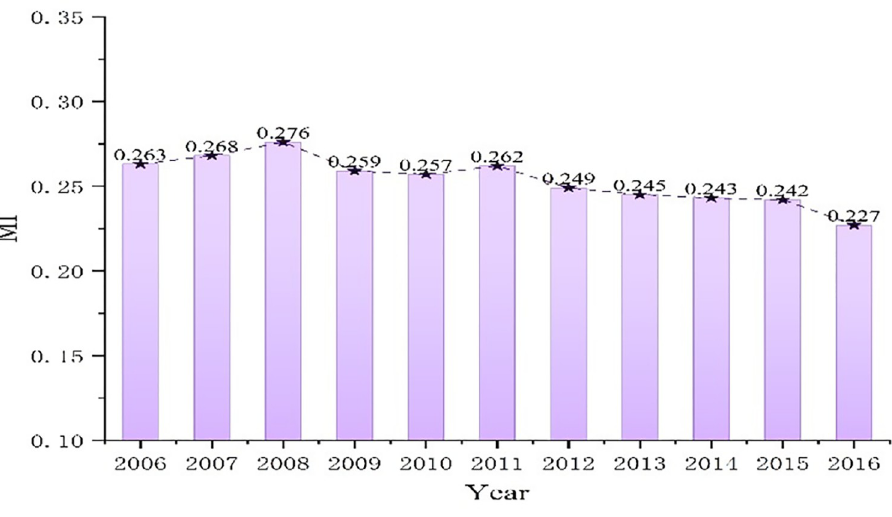
Fig 4. Changing trend of Moran’s